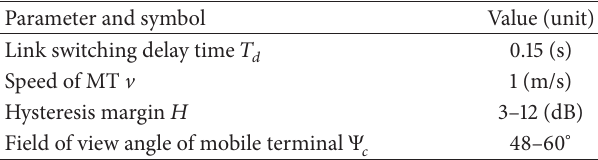
Table 3: Additional system